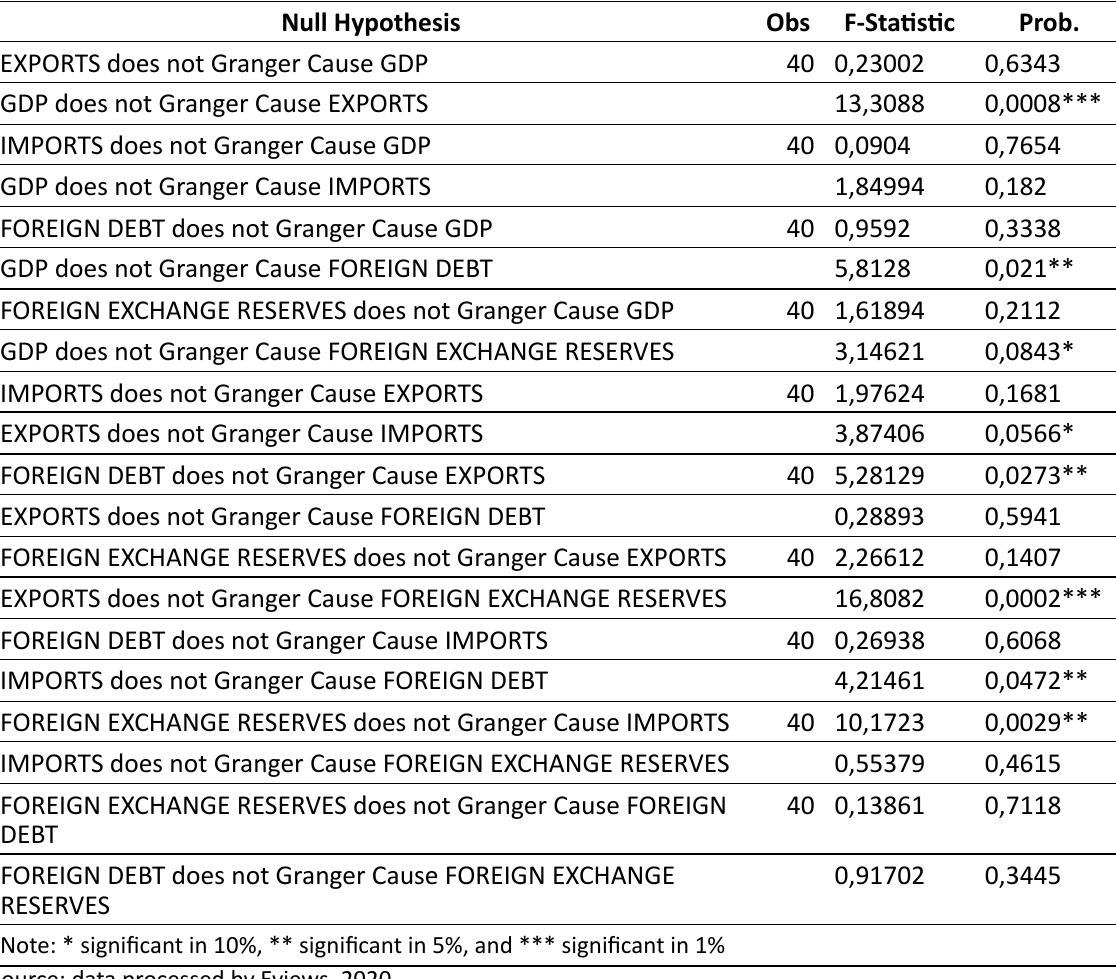
Table 3: Granger Causality